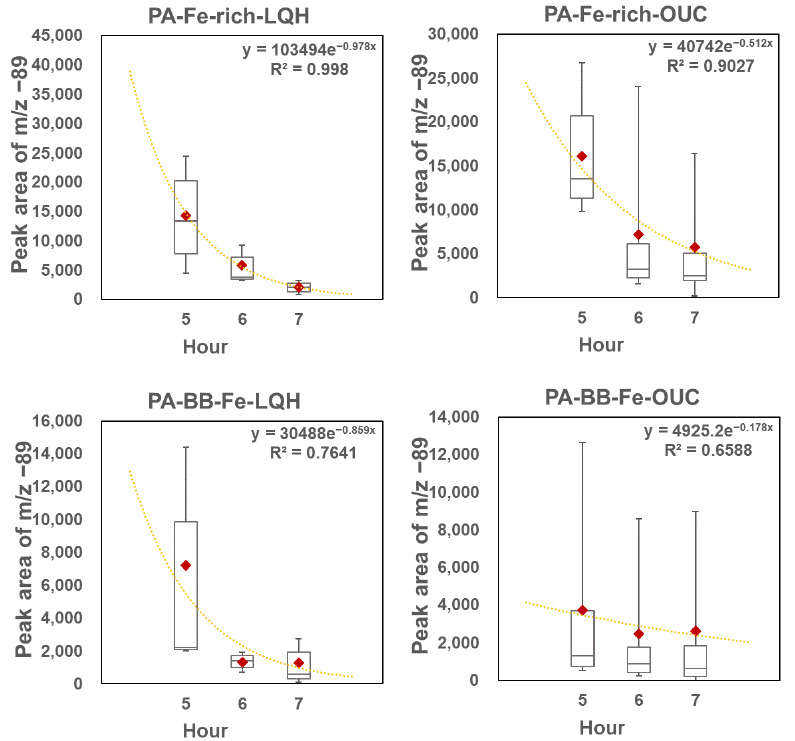
Figure 5. Average decay estimation of oxalate intensity in different oxalate-Fe complexes. (Plotted by particle PA of m / z − 89; box and error bars represent the 10th, 25th, 50th, 75th, and 90th percentiles; and the red diamond represents the mean).